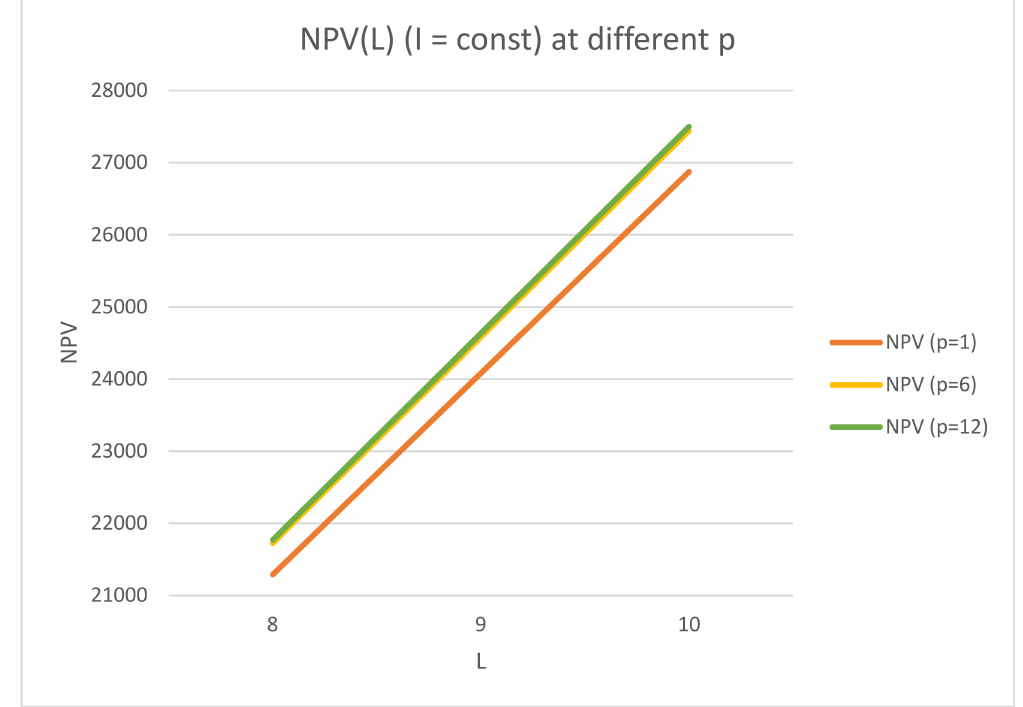
Figure 7. Dependence of NPV on leverage level L at k 0 = 0.22, k d = 0.14 and different p = 1, 6, 12 for a long-term project (larger